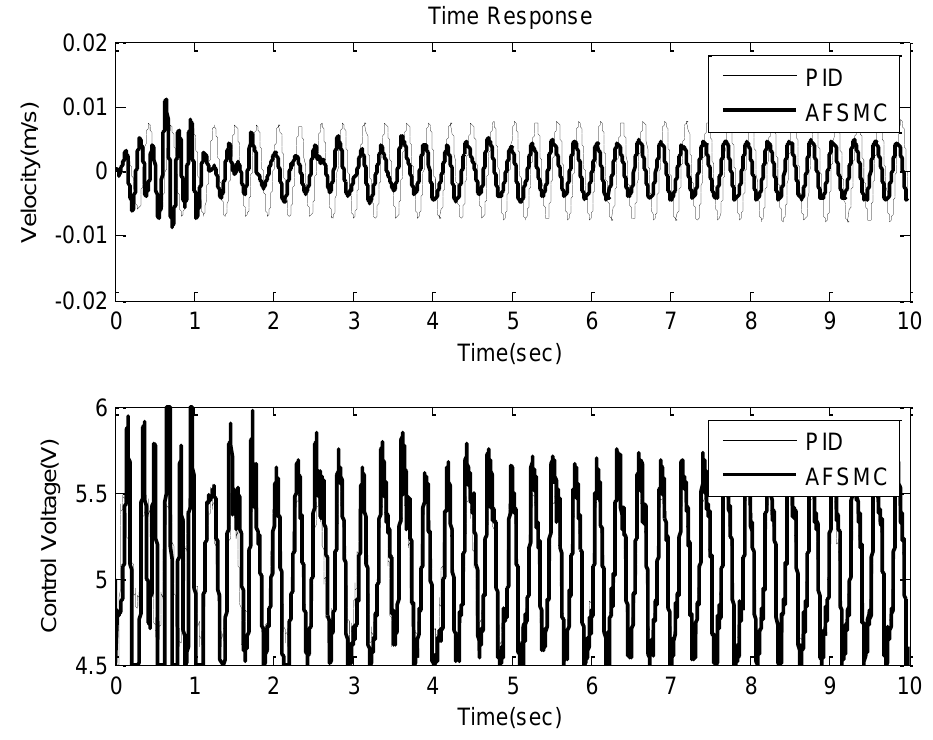
= 1, k = 0.01, k = 0.5) isolator under sinusoidal disturbance. p i d